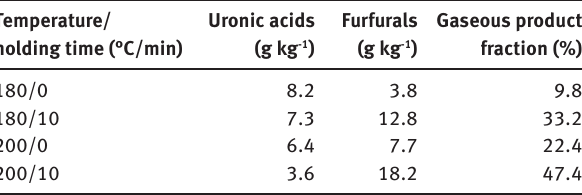
Table 2: Effect of reaction temperature and holding time on the yield of uronic acids and furfurals and gaseous product fractions obtained at 180°C and 200°C.